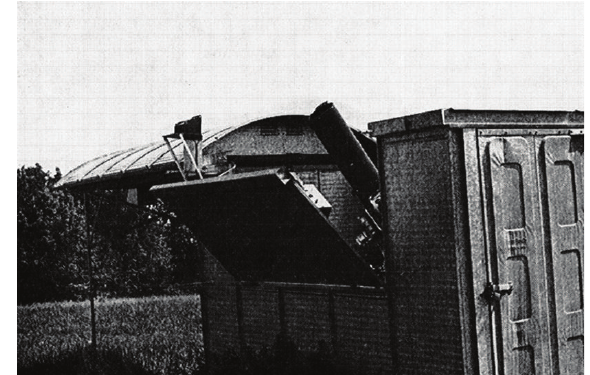
Figure 2: The first computer-controlled telescope ever built, at University of Wisconsin, 1968, adapted from